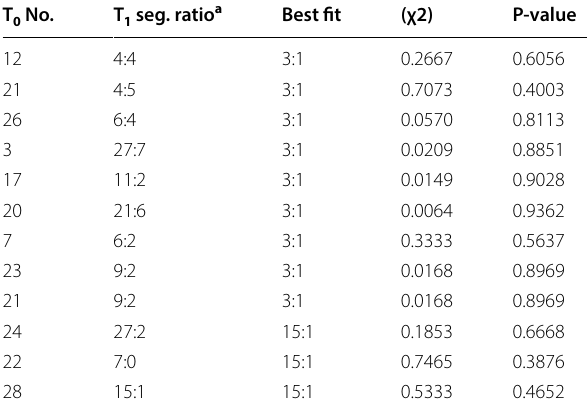
Table 2 Segregation analysis of 209 T transgenic plants progenies